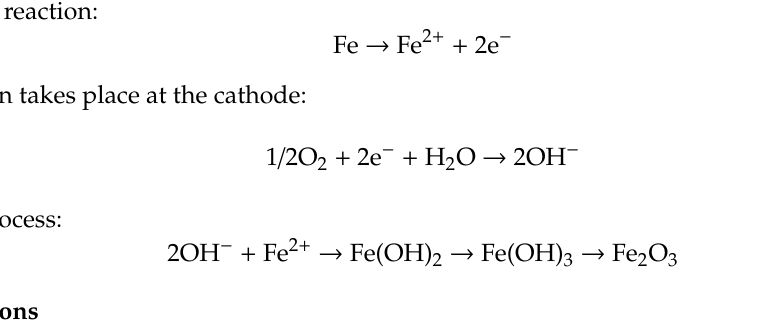
Figure 11. Schematic diagrams of the mechanism of CRS passivation by EIO coatings.